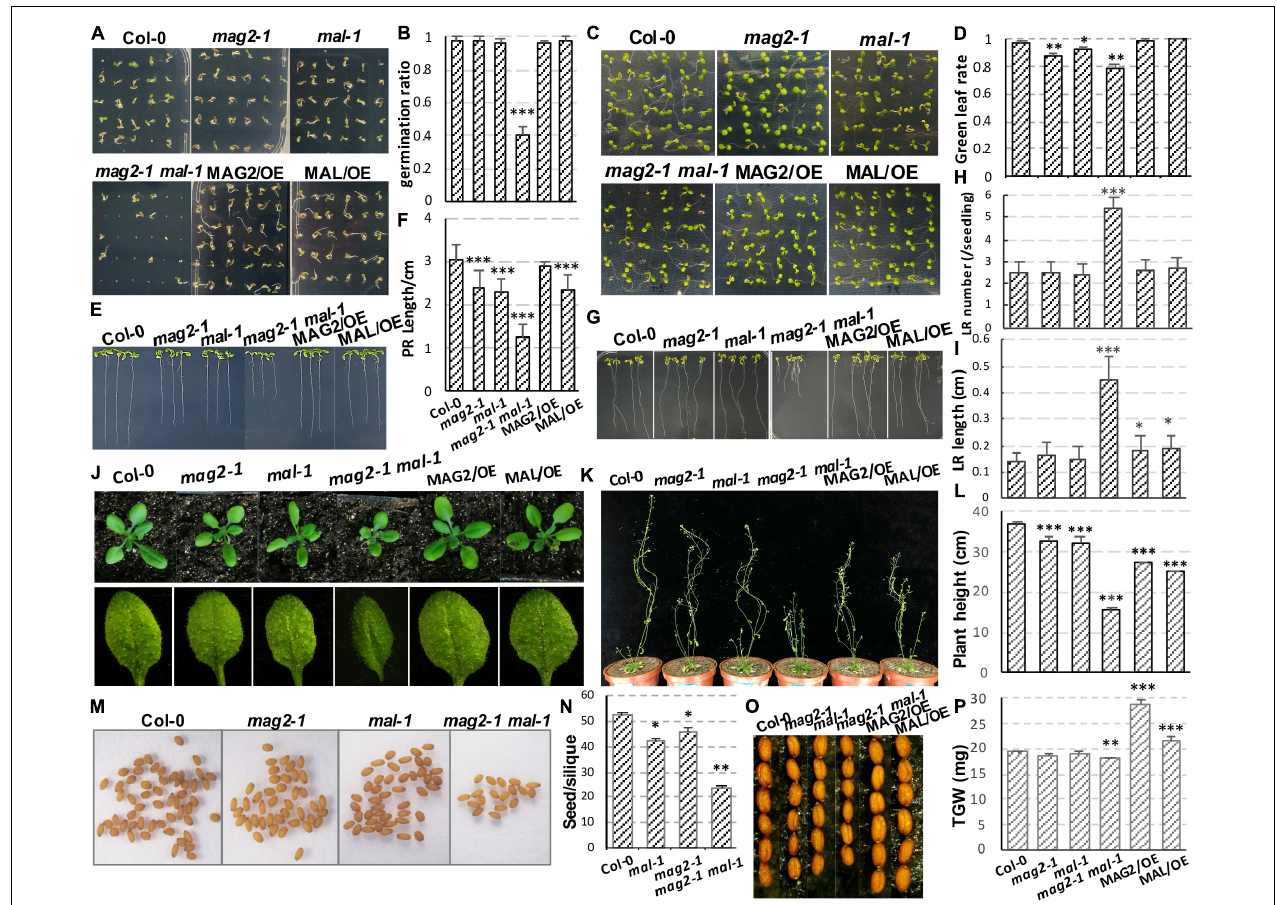
FIGURE 2 | MAG2 and MAL regulate plant growth and development with redundancy. (A) Three-day-old seedlings grown in the 1/2 Murashige and Skoog (MS) medium. (B) Statistics of germination ratio in panel (A) . Values are means ± SD; n = 36, three repeats per sample. (C) Six-day-old seedlings grown in the 1/2 MS medium. (D) Statistics of green leaf ratio in panel (C) . Values are means ± SD; n = 36, three repeats per sample. (E) Seven-day-old seedlings grown in the 1/2 MS medium vertically. (F) Statistics of primary root length in panel (E) . Values are means ± SD; n = 30, three repeats per sample. (G) Fourteen-day-old seedlings grown in the 1/2 MS medium vertically. (H) Statistics of lateral root number of seedlings in panel (G) . Values are means ± SD; n = 10 PR, three repeats per sample. (I) Statistics of lateral root length in panel (G) . Values are means ± SD; n = 30, three repeats per sample. (J) Thirty-six-day-old plants and their rosette leaves. (K) Seventy-day-old plants. (L) Statistics of plant height in panel (K) . (M) Seeds in one silique from indicated lines. (N) Statistics of seed number per silique of panel (M) . (O) Seed size comparison. (P) Statistics of thousand grain weight. PR, primary root; LR, lateral root; TGW, thousand grain weight. ∗ p < 0.05, ∗∗ p < 0.01,